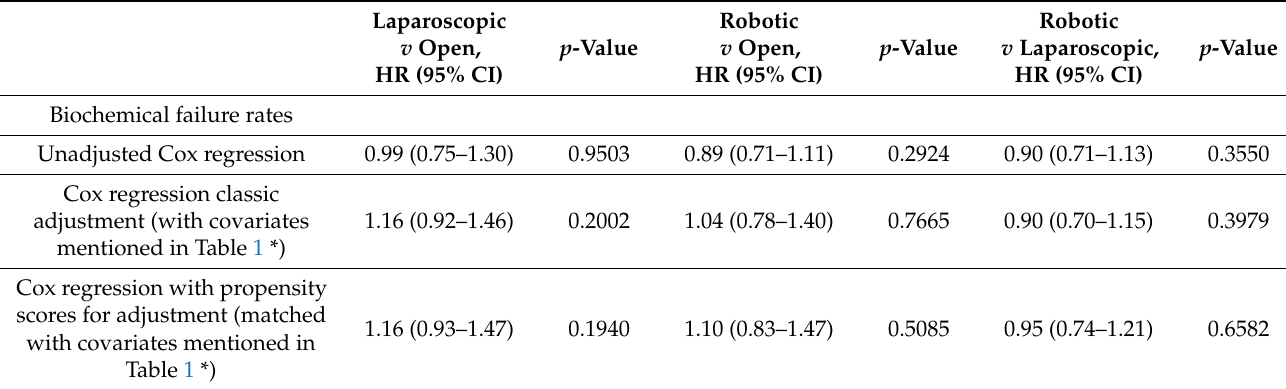
Table 4. Cox Regression Analysis of Biochemical Failure Rates by Surgical